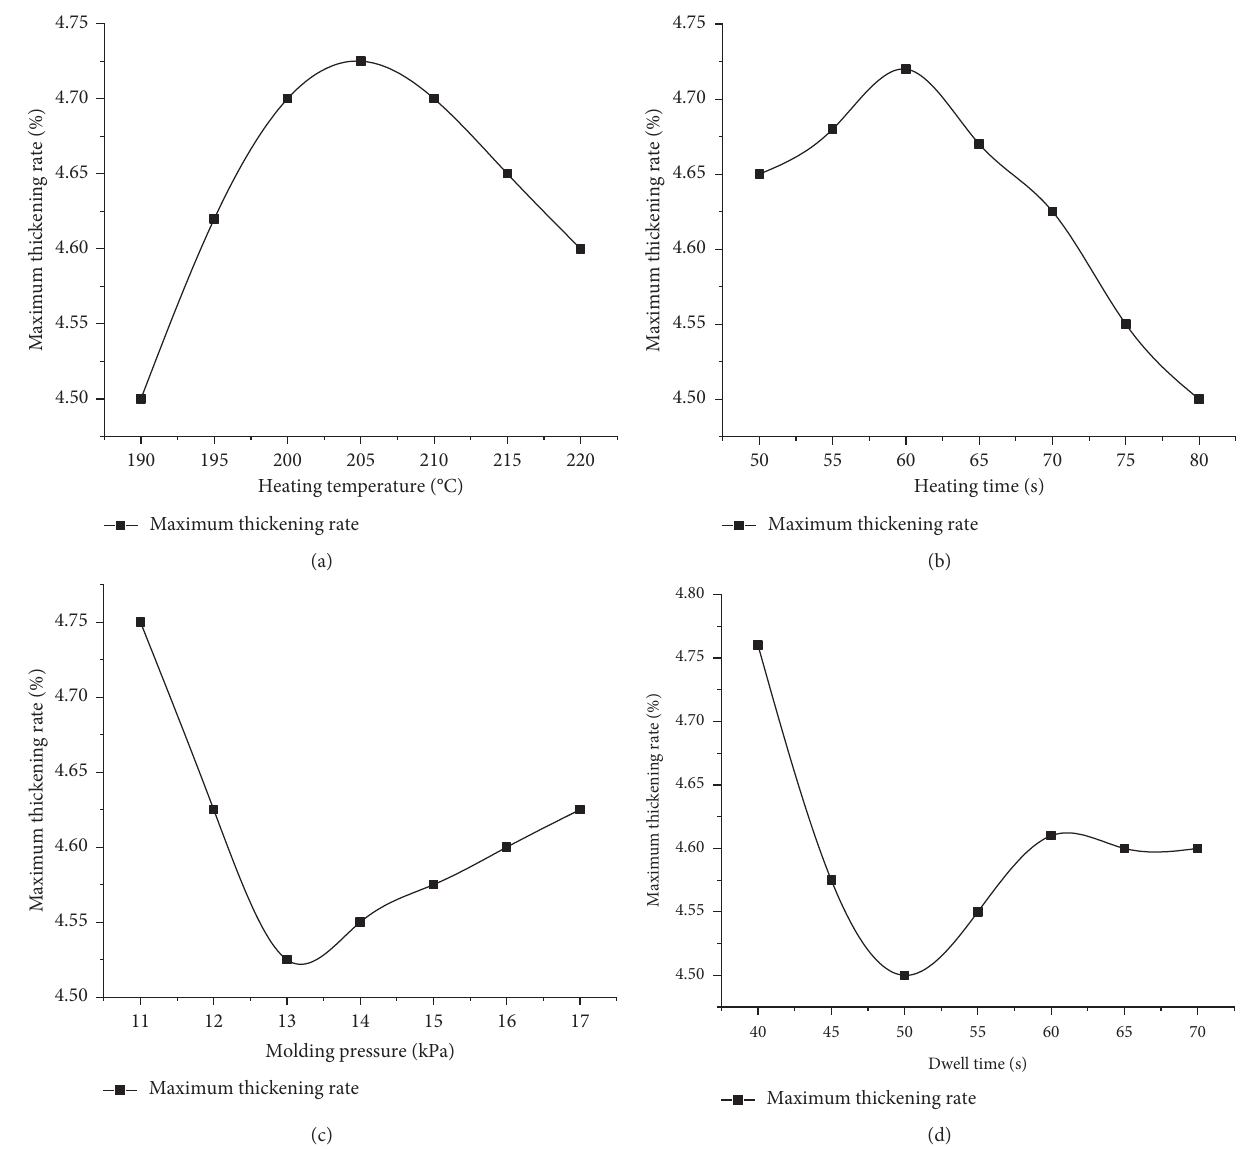
Figure 24: Trend of maximum thinning rate with process parameters. (a) Trend of maximum thickening rate with heating temperature. (b) Trend of maximum thickening rate with heating time. (c) Trend of maximum thickening rate with molding pressure. (d) Trend of maximum thickening rate with dwell